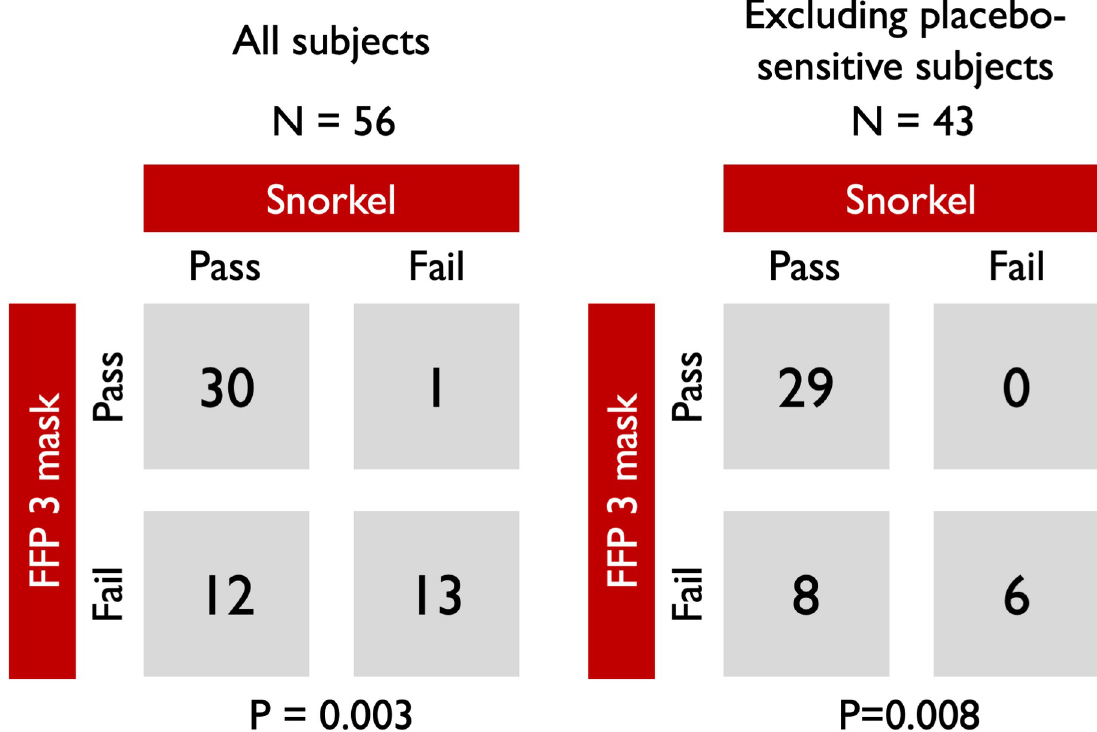
Fig 1. Comparison of fit testing pass rates between the adapted snorkel mask and standard FFP3 mask. Left panel: all participants. Right panel: excluding those sensitive to placebo.